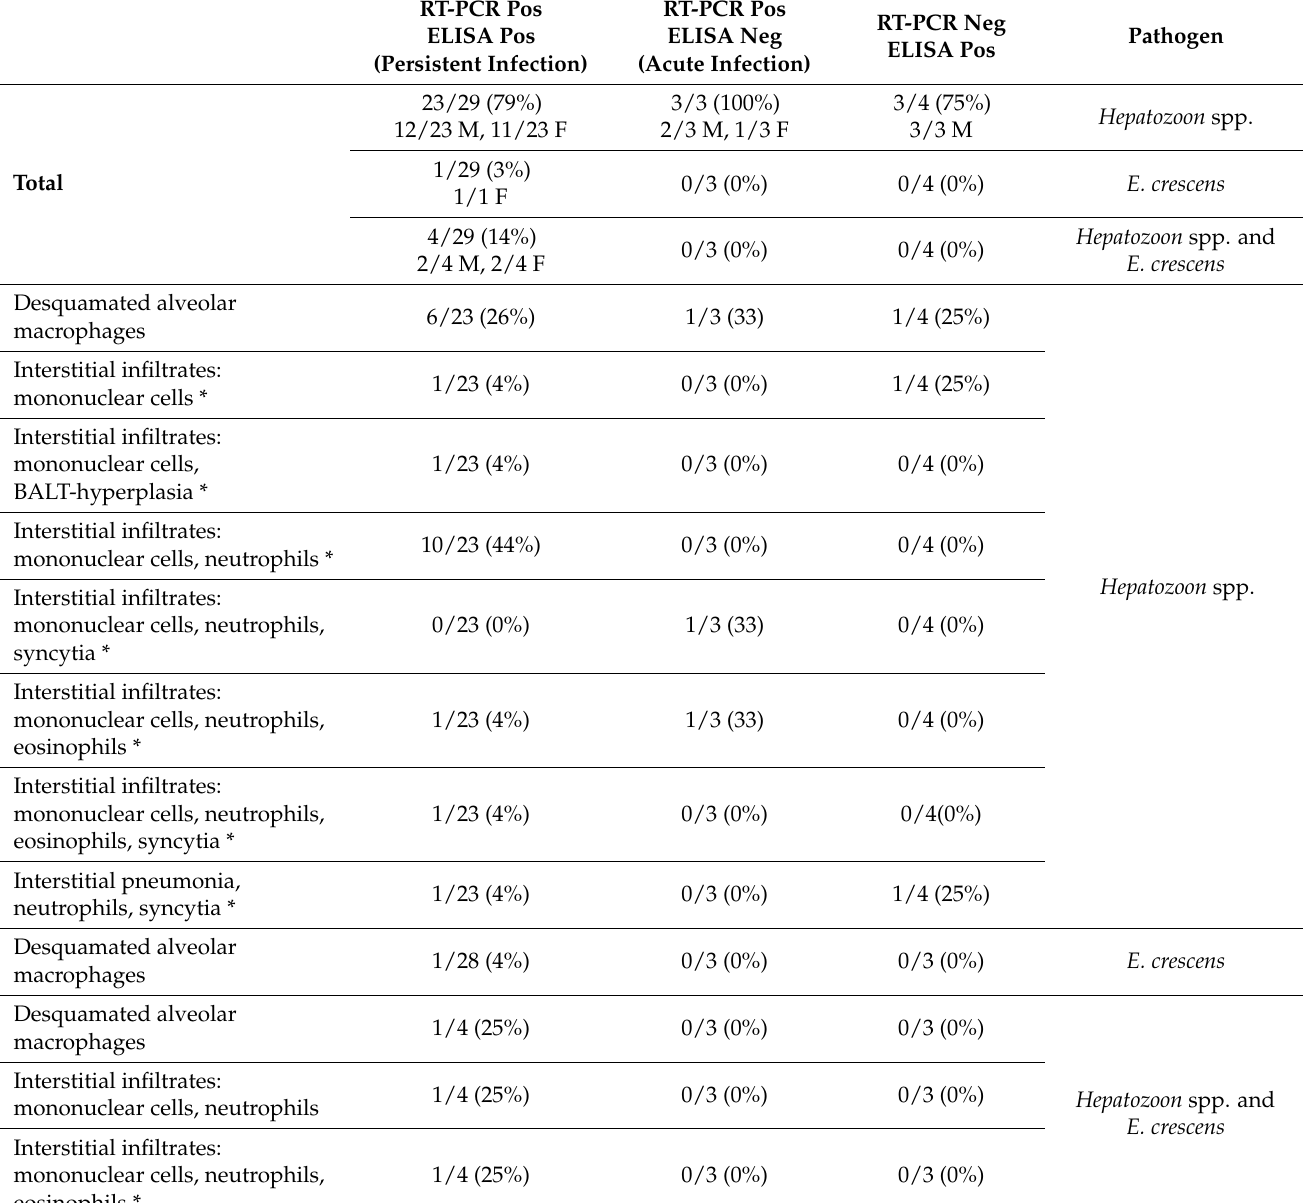
Table 5. Histologic findings in the lungs of bank voles from OS affected with Hepatozoon spp., Emmonsia crescens or both